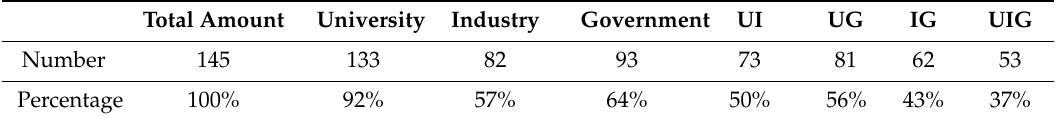
Table 2. Triple Helix relations in the Portuguese defense industry.